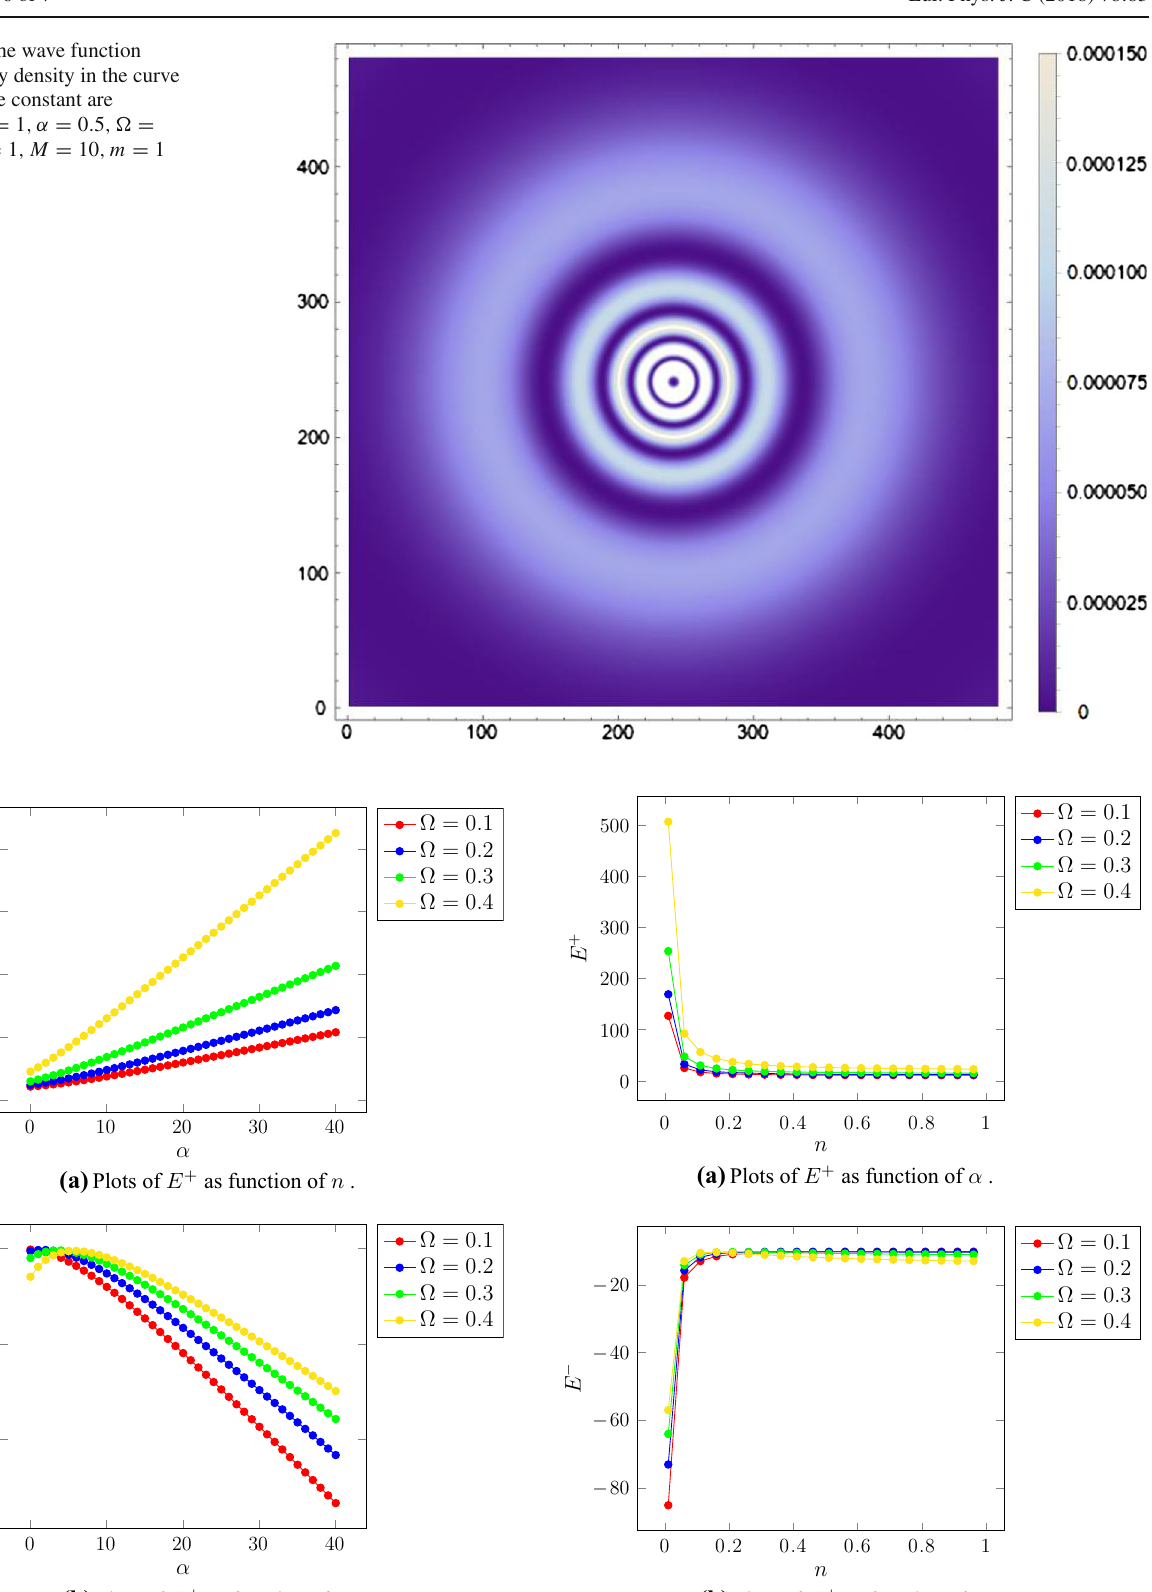
Fig. 2 Energy as a function of α . The constants have been set as α = 0 . 5 , k = 1 , R = 1 , M = 10 , m = 1